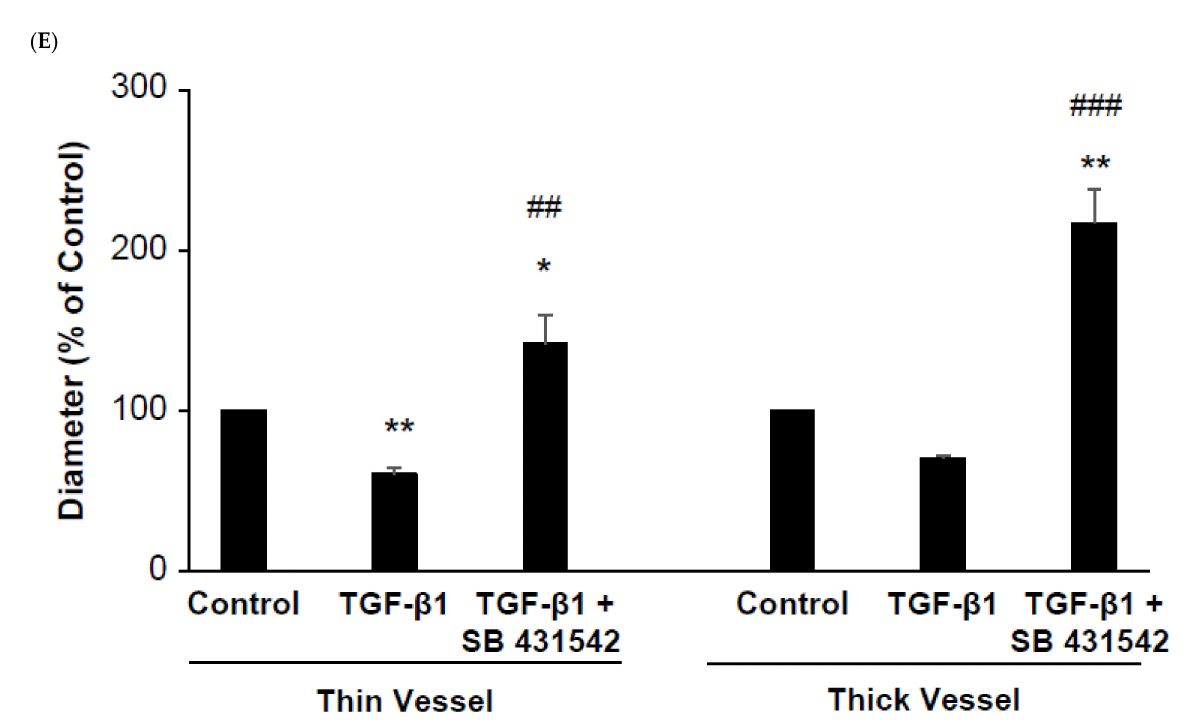
Figure 2. KRT8 expression in HK-2 and total length and diameter of the HUVECs. (A) Immunofluorescence shows that the expression of α -SMA was maintained and KRT8 expression was dramatically decreased by treatment of TGF- β 1 in HK-2. Cells were plated and stimulated with 5 ng/mL TGF- β 1 or 10 µ m inhibitor (SB 431542) for 24 h and fixated with 4% paraformaldehyde. The cells were stained with anti- α -SMA and anti-cytokeratin-8 for 20 min. Co-staining with Hoechst dye H33342 to identify cell nuclei was performed. The expression of α -SMA ( a–c ) had no alteration but KRT8 ( d–f ) in HK-2 cells and GFP in HUVEC ( g–i ) expression were significantly changed by TGF- β 1 (5 ng/mL) and the inhibitor ( B , C ). In the total length of the HUVECs, the thin vessel was increased but the thick vessel was decreased by TGF- β 1. The diameter was increased in both the thin and thick vessels. These results were reversed by the inhibitor SB431542 ( D , E ). Scale bars in the micrographs indicate 100 µ m. * p < 0.05, ** p < 0.01, *** p < 0.001 versus the control group; ## p < 0.01, ### p < 0.001 versus the TGF- β 1 group. Each value represents three technical replicates of each of the three biological replicates. Statistical significance of the length compared to the non-treated cells is represented in the graph. Thin vessels mean a length shorter than 50 µ m and thick vessels represent a length longer than 50 µ